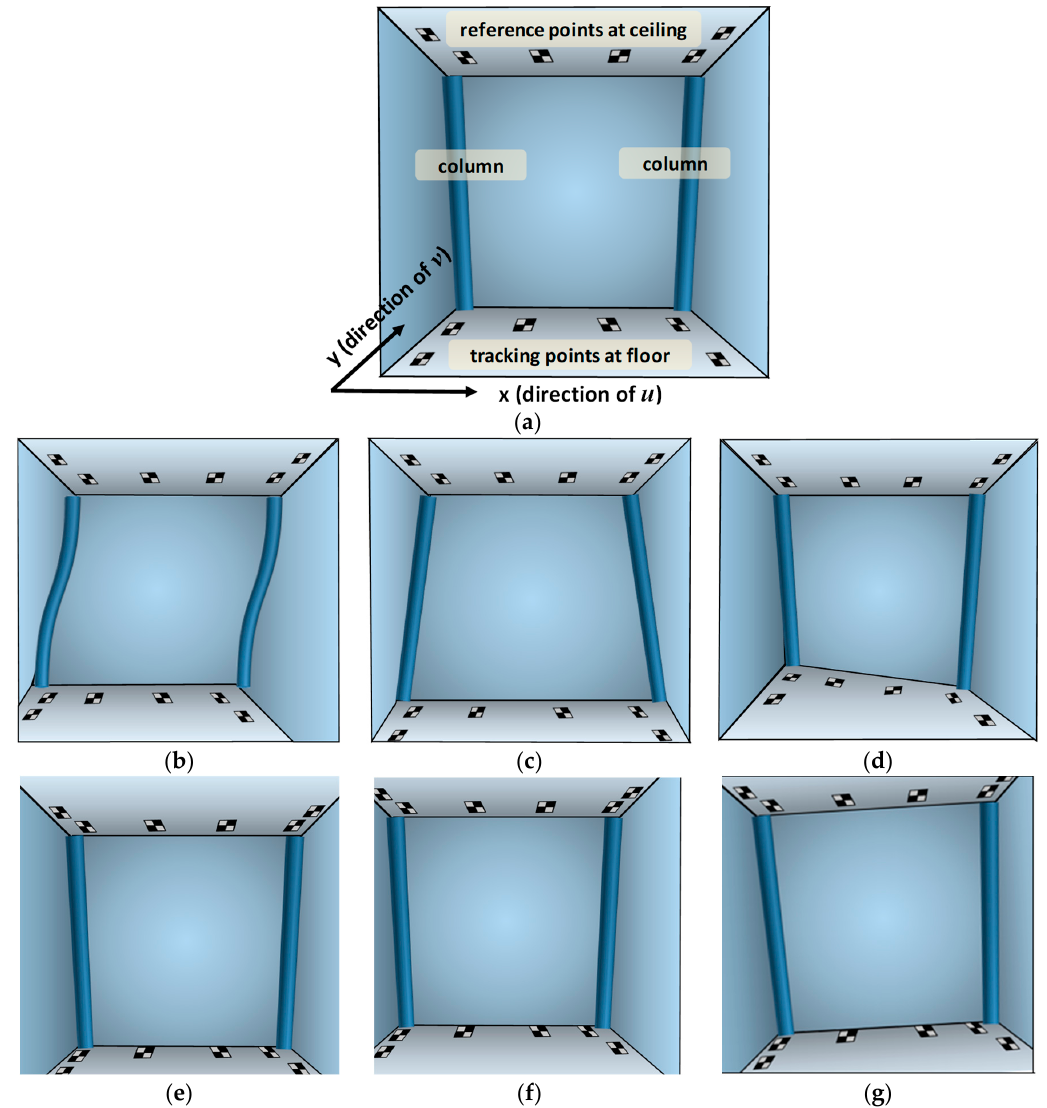
Figure 4. Demonstration of images taken by a camera that represent different inter-story responses and camera movement. ( a ) Un-deformed inter-story. ( b ) Response to u . ( c ) Response to v . ( d ) Response to torsion 𝜃 . ( e ) Camera pitch. ( f ) Camera yaw. ( g ) Camera roll.